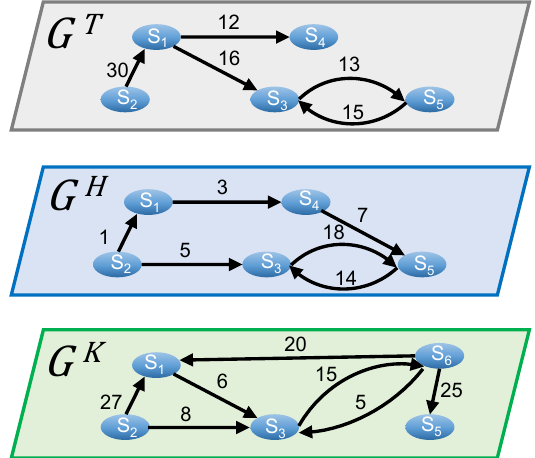
Figure 3. An example of the